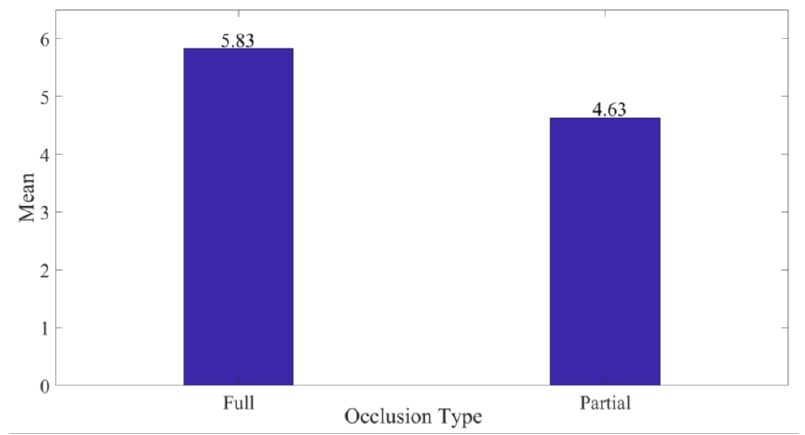
Figure 13. Average Utility against Occlusion Type.